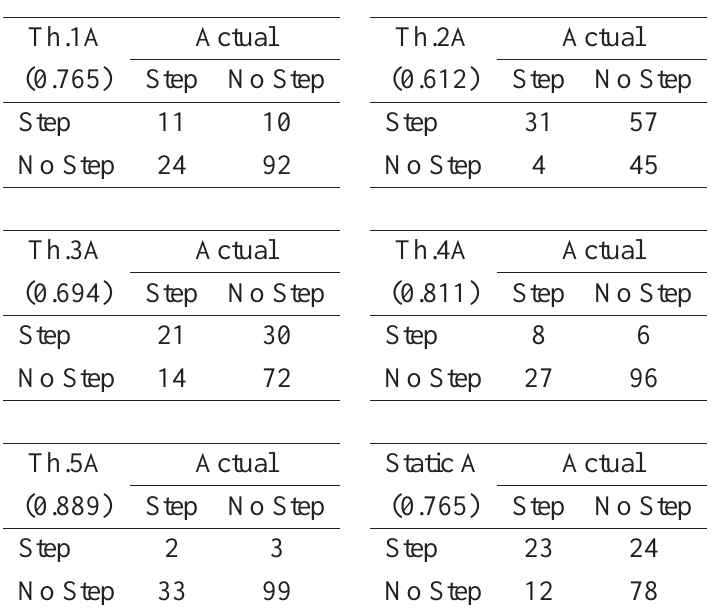
Table 3 . 2 × 2 contingency tables for each threshold for anterior perturbations. The values in the brackets indicate the step